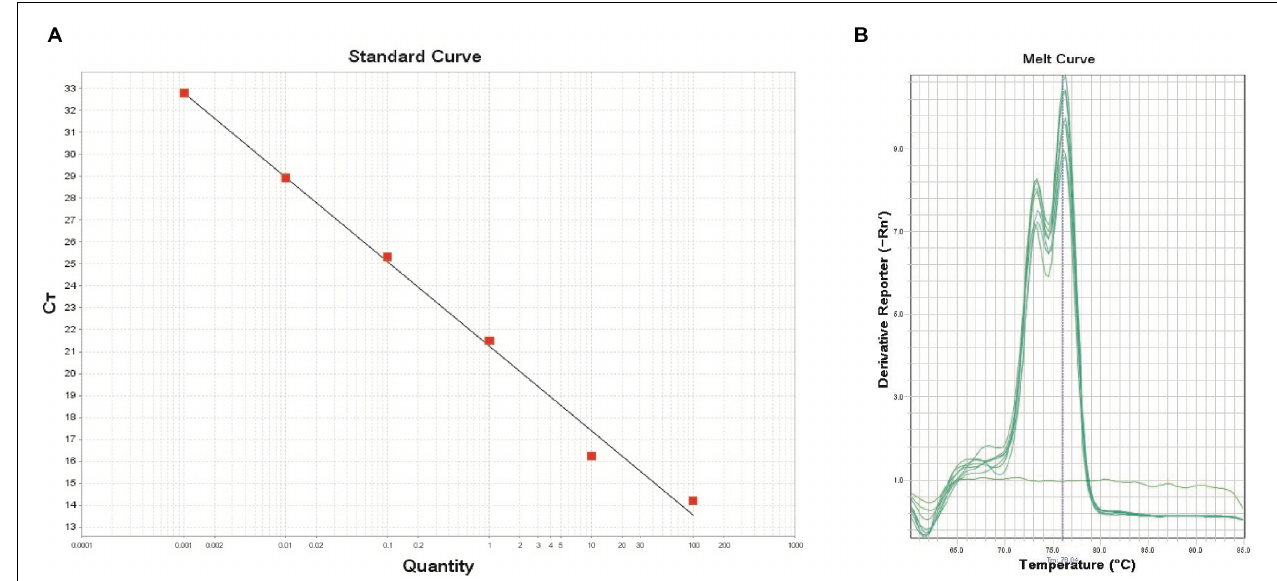
FIGURE 2 | Standard curve (A) using the primer XRE ( R 2 : 0.993, Eff%: 81.8) and melt curve peaks (B) for the detection of the transcriptional regulator and crystal protein genes in the B. thuringiensis strain. The DNA concentrations of B. thuringiensis ATCC 10792 were as follows: 1.0 × 10 2 , 1.0 × 10 1 , 1.0 × 10 0 , 1.0 × 10 − 1 , 1.0 × 10 − 2 , and 1.0 × 10 − 3 ng (from left to right). DNA amounts correspond to 2.6 × 10 6 , 2.6 × 10 5 , 2.6 × 10 4 , 2.6 × 10 3 , 2.6 × 10 2 , and 2.6 × 10 1 CFU, respectively.